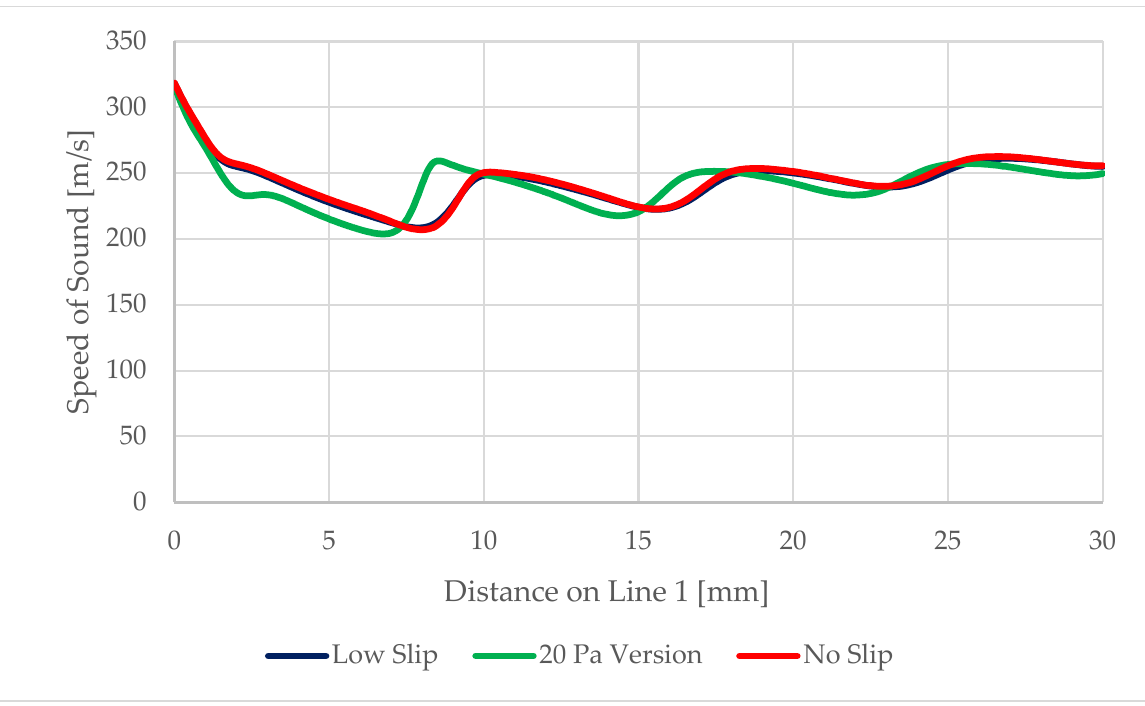
Figure 24. Speed of sound on Line 1.